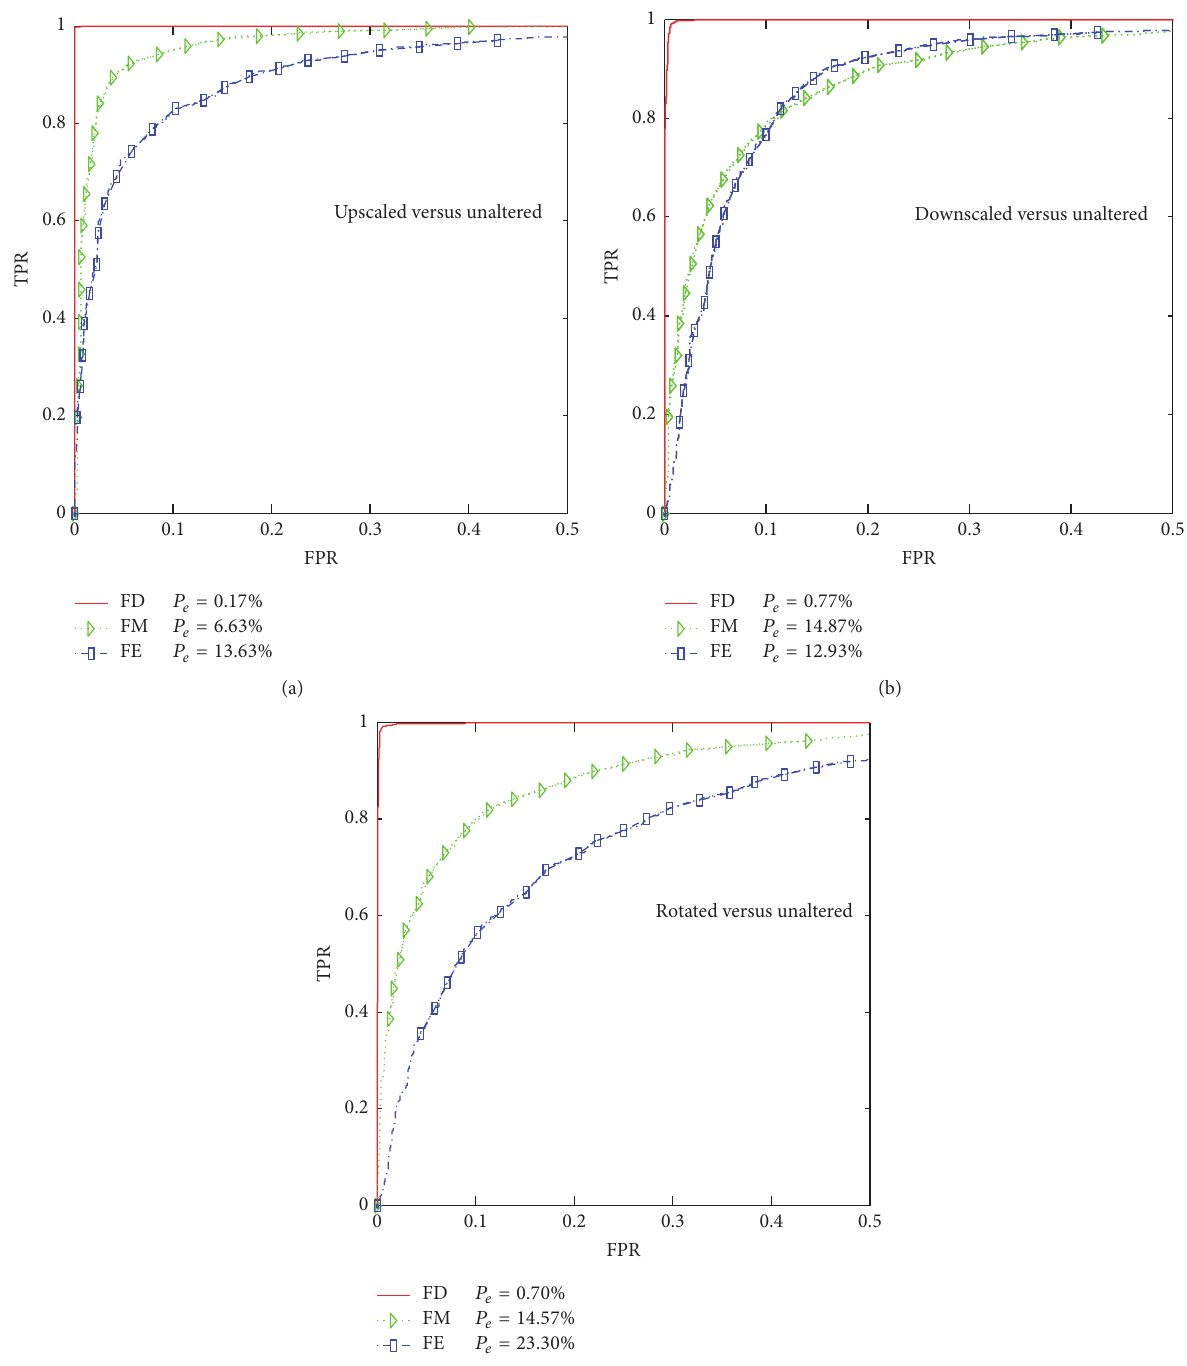
Figure 6: ROC curves showing detections of (a) upscaling, (b) downscaling, and (c) rotation under uncompressed scenario.